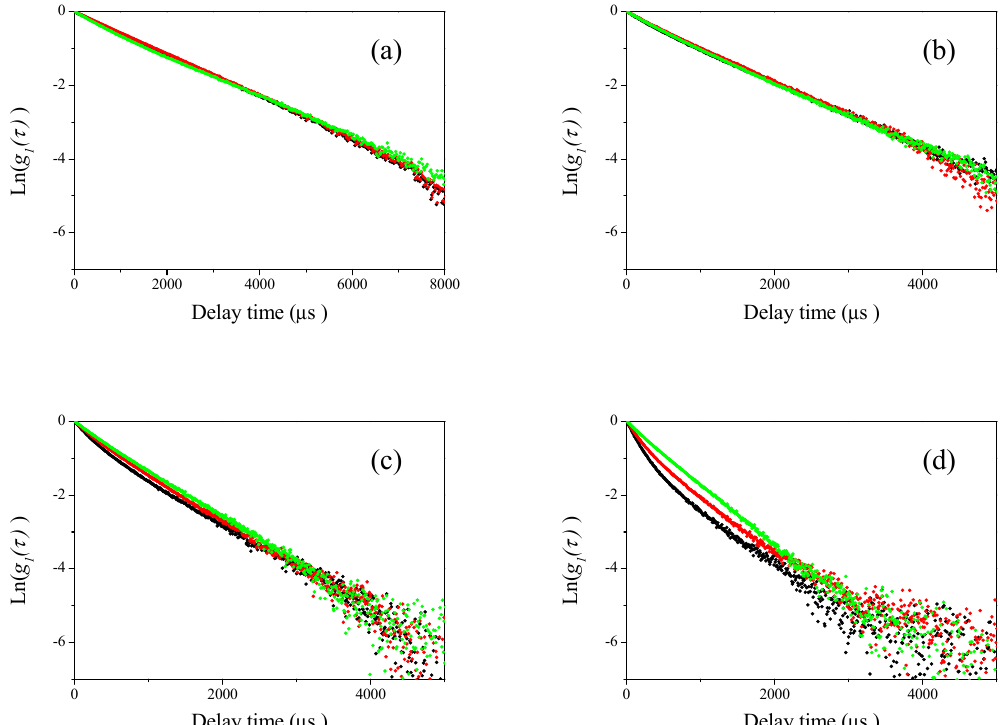
Figure 6. Examples of observed homodyne photon correlation functions for polystyrene latex particles measured with the DLS method (70-350-1 (black), 70-350-2 (red), and 70-350-3 (green)). ( a ) Light scattering was observed at a detector angle of 60°; ( b ) light scattering was observed at a detector angle of 90°; ( c ) light scattering was observed at a detector angle of 120°; and ( d ) light scattering was observed at a detector angle of 150°.